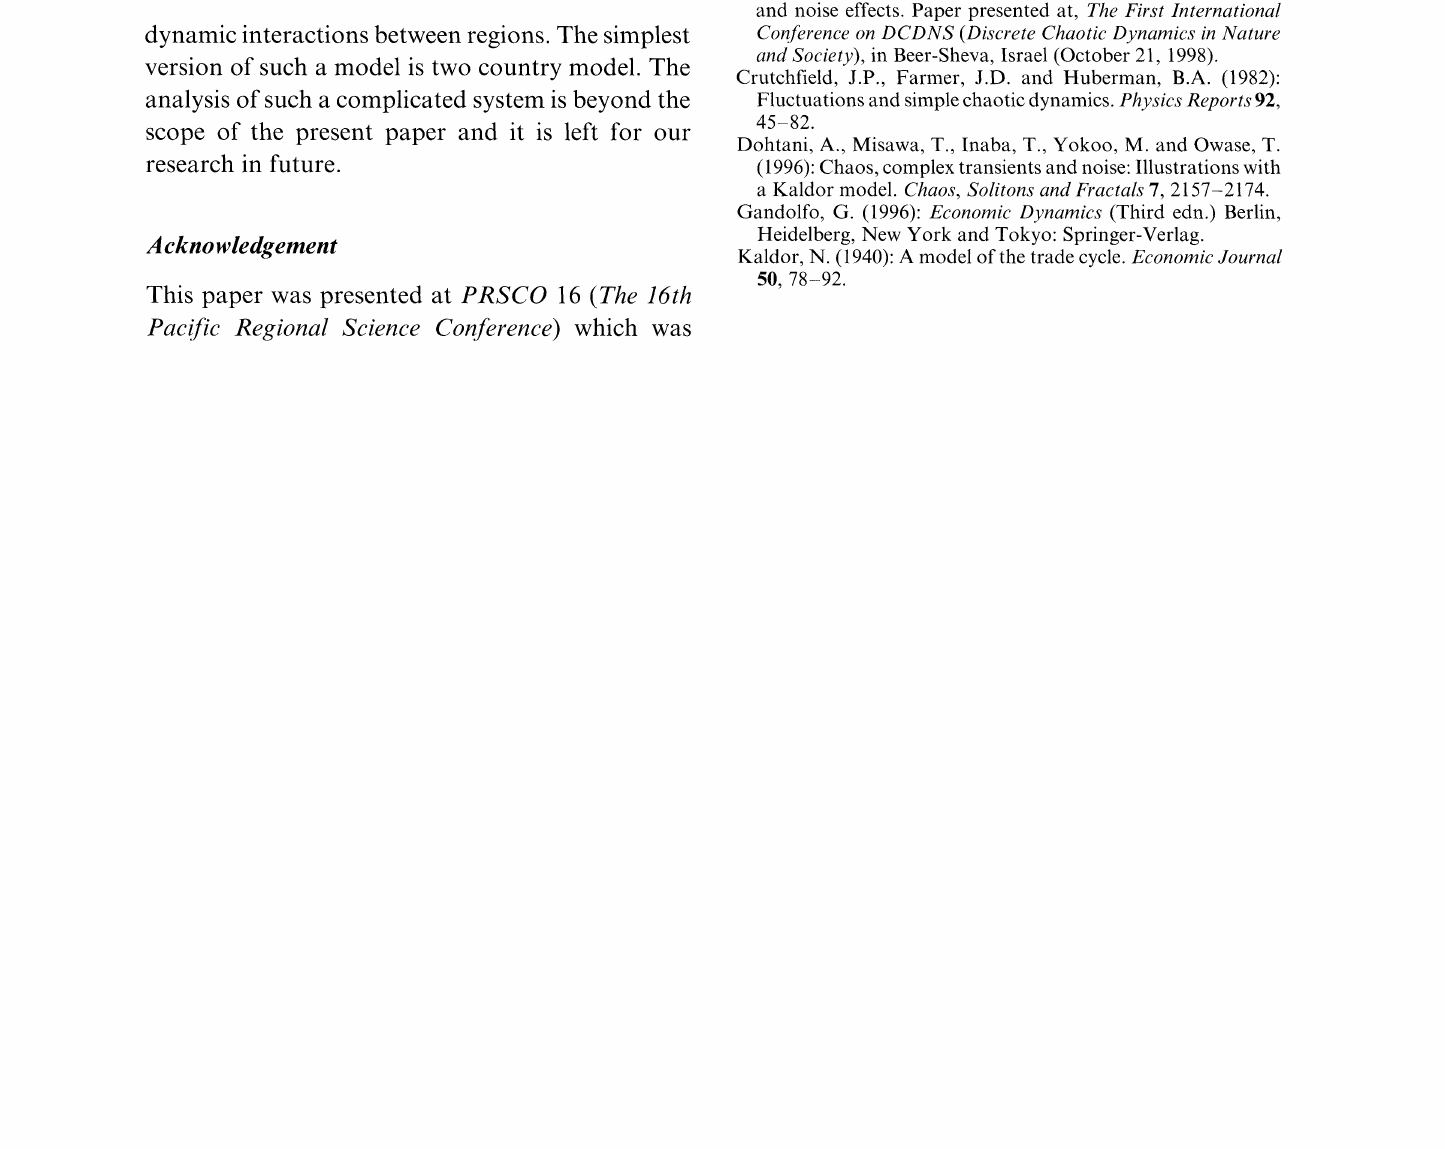
FIGURE 11 The largest Lyapunov exponent with